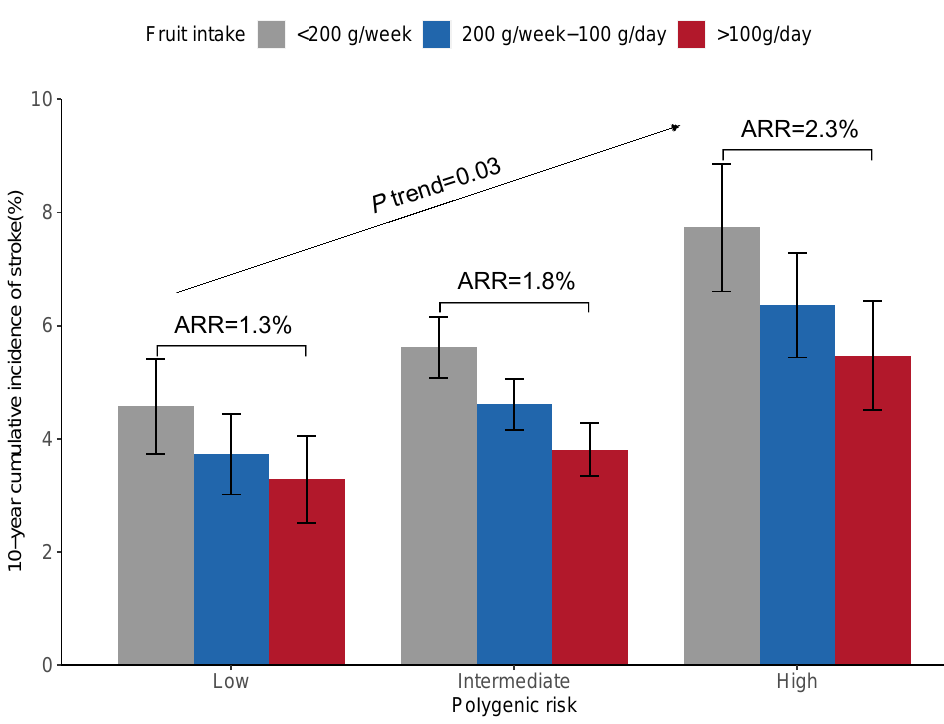
Figure 2. Adjusted 10-year cumulative incidence of stroke according to the genetic risk and fruit intake. Standardized to the means of cohort, age, sex, region, urbanization, education level, current smoking status, alcohol drinking status, physical activity, body mass index, diet score, and vegetables intake within the study population. Abbreviations: ARR, absolute risk